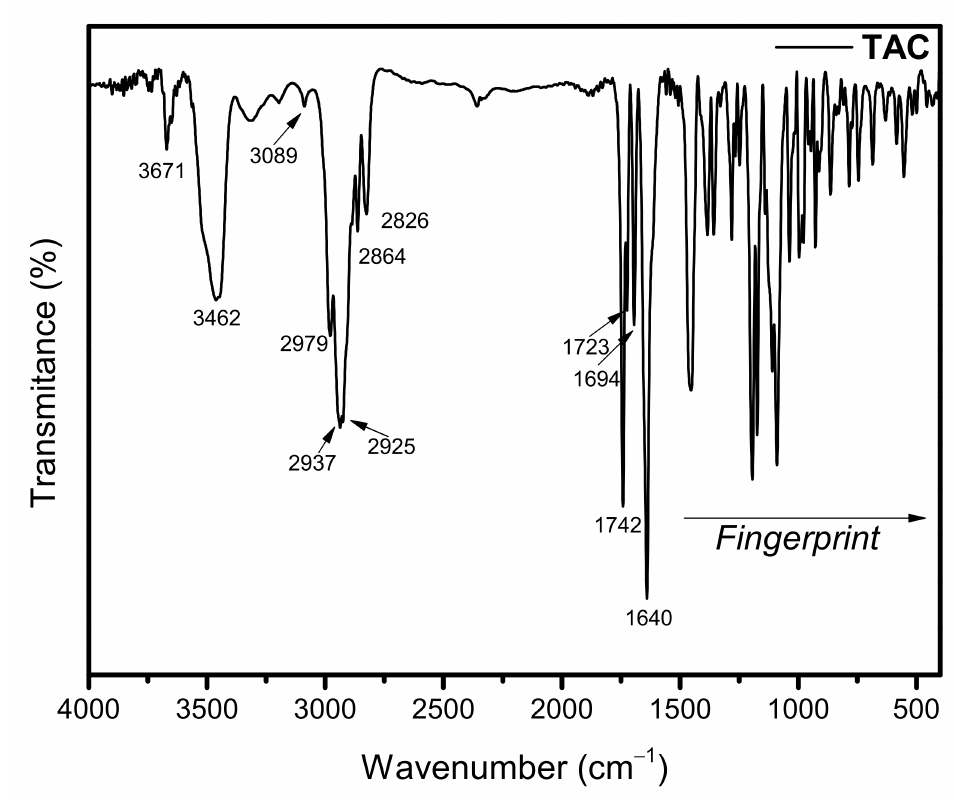
Figure 4. FTIR spectrum of